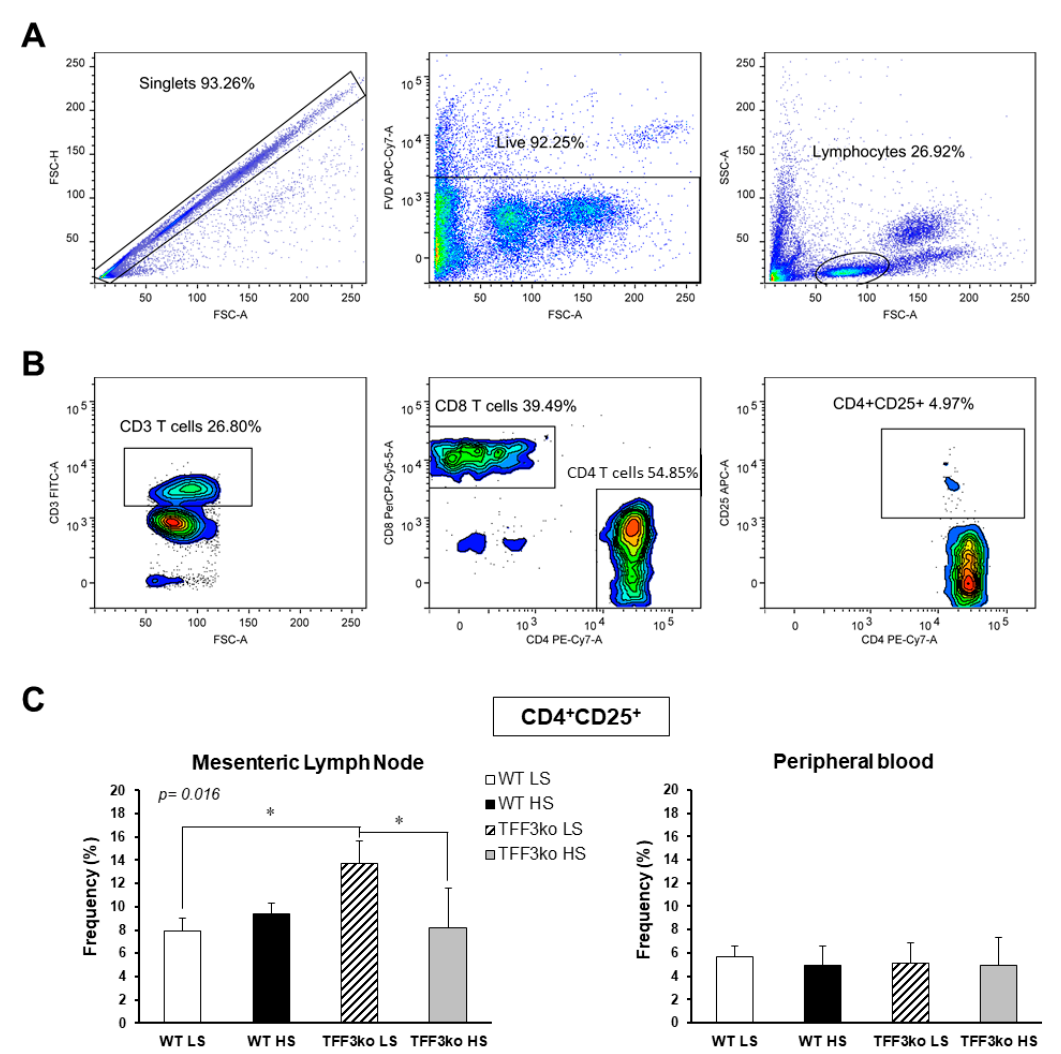
Figure 4. Rates of CD25 expressing CD4 T cells in the peripheral blood and mesenteric lymph nodes (MLNs) of Tff3 -deficient mice and their respective wild-type controls exposed to a 7-day high-salt diet. Panel A and B demonstrate the representative gating strategy, including gating on live single cells and lymphocytes based on forward and side scatter ( A ), followed by gating on CD3 + CD4 + CD25 + T cells ( B ). ( C ) shows the changing rates of CD4 + CD25 + in MLNs and peripheral blood in both study groups following the HS diet. MLNs—mesenteric lymph nodes; HS—high salt; WT LS—wild-type (C57BL/6N) mice on a low-salt diet; WT LS—wild-type (C57BL/6N) mice on a high-salt diet; TFF3ko LS— Tff3 knock-out mice on a low-salt diet; TFF3ko HS— Tff3 knock-out mice on a high-salt diet. Data are presented as mean ± SD and were analyzed by one-way ANOVA or Kruskal–Wallis test where appropriate. In some cases, the effect of the diet on a particular strain (TFFko or WT) was tested by Student’s t -test or Mann–Whitney U test; * p -values less or equal 0.05 are considered significant. A representative gating strategy for CD3 + γδ TCR + T cells is shown in Figure 5A. TFF3ko-LS had significantly lower rates of CD3 + γδ TCR + cells compared with the WT-LS mice (Figure 5B). Furthermore, the 7-day HS diet reduced CD3 + γδ TCR + frequency in WT mice while increasing it in the TFF3ko group ( p = 0.002; Figure